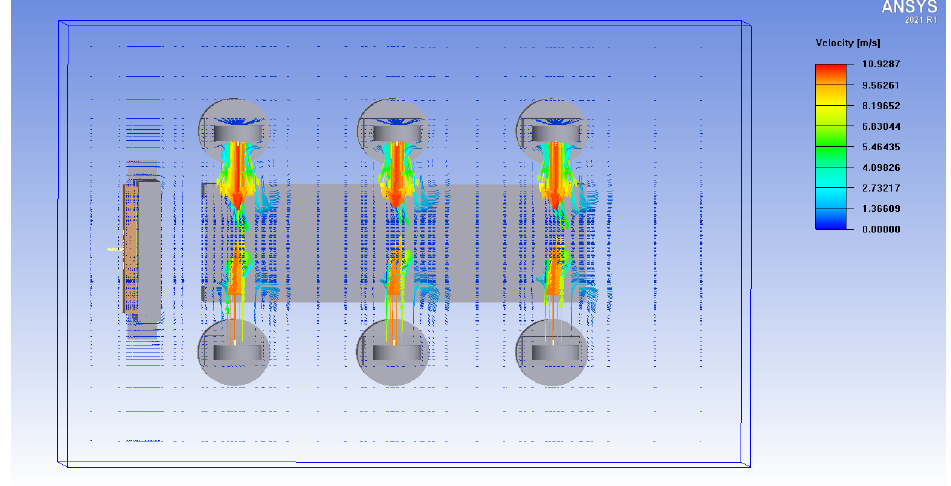
Figure 29. Air purifier simulation top view in the conference room at a high rotation speed -1.